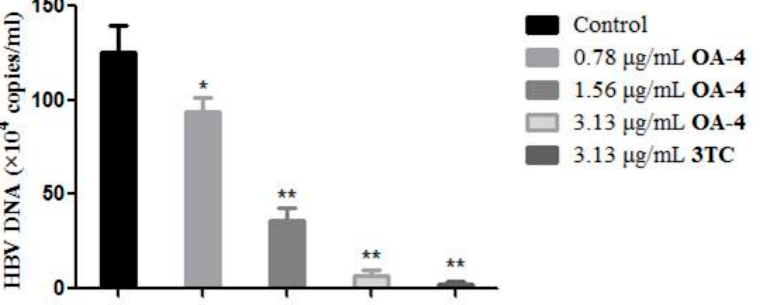
Figure 5. Inhibitory effect of OA-4 and 3TC on HBV DNA expression in HepG2.2.15 cells. HBV DNA levels were quantified by fluorescence quantitative PCR. Data are expressed as HBV DNA copies ± SD based on three independent experiments. ** p < 0.01, * p < 0.05 compared with the control group.